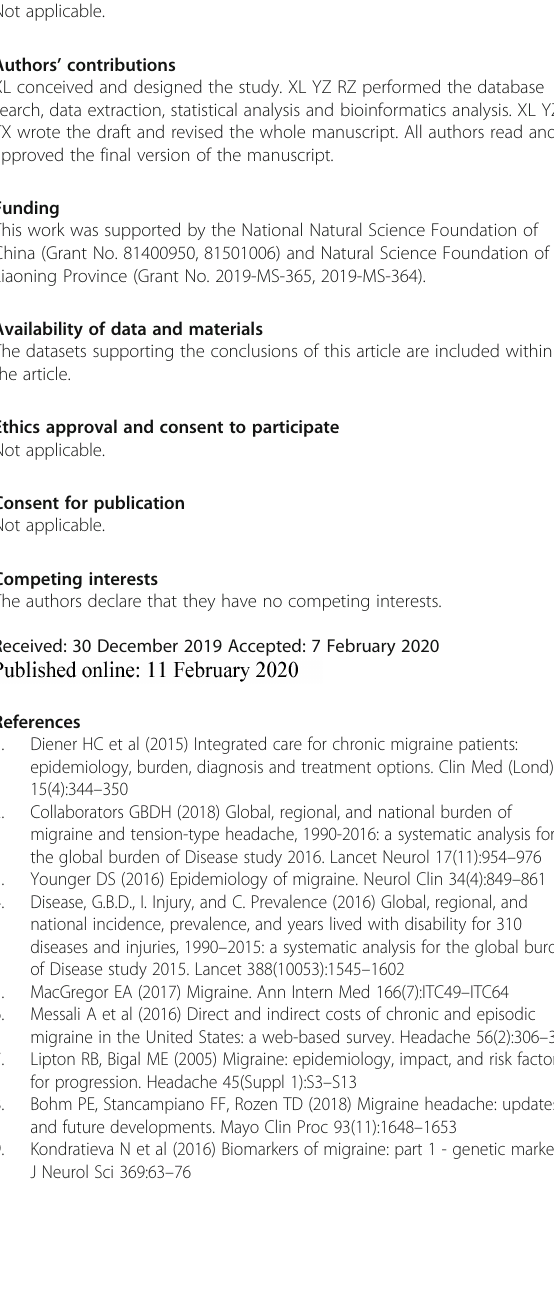
Additional file 1: Table S1. Overall summary of results from meta- analyses of observation studies on risk of migraine (including duplicates, statistically significant and non-significant results). Additional file 2: Table S2. Overall summary of results from meta- analyses of GWAS on risk of migraine (including duplicates, statistically Additional file 3: Figure S1. Protein-protein interaction network of noteworthy genes related with migraine. The active interaction